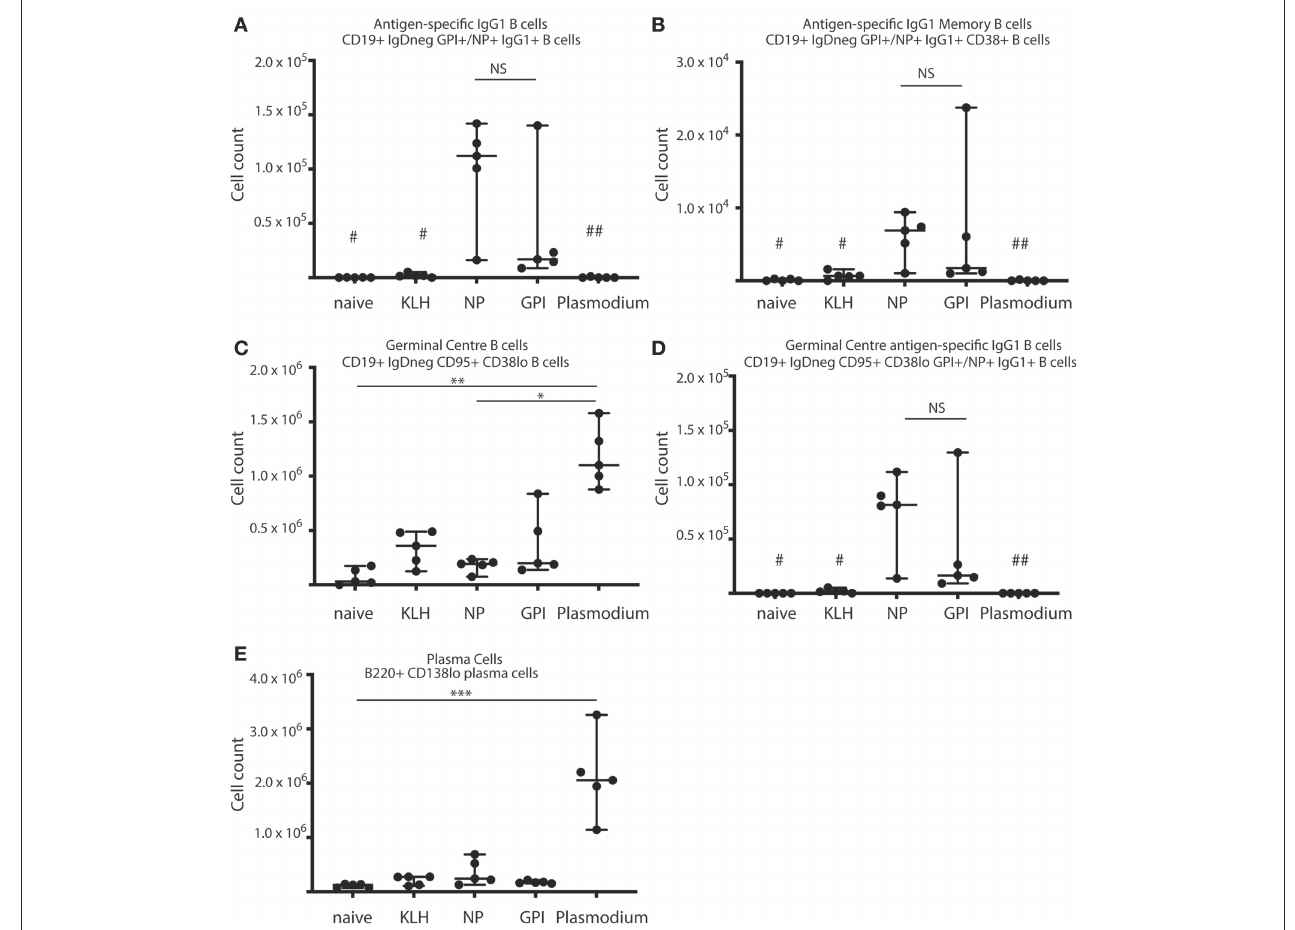
FIGURE 1 | Synthetic GPI-KLH vaccination induced B cell activation. Mice were vaccinated and boosted with NP-KLH ( n = 5), GPI-KLH ( n = 5), or KLH alone ( n = 5) (20 µ g/ µ L) or infected twice with 10 6 pRBCs then 10 4 pRBCs (Plasmodium, n = 5). Naïve mice ( n = 5) were included as a baseline. At day 21, activated B cell populations were analyzed by flow cytometry and the number of cells per spleen for (A) antigen-specific IgG1 B cells, (B) antigen-specific IgG1 memory B cells (MBCs), (C) germinal center (GC) B cells, (D) antigen-specific IgG1 GC B cells, and (E) Plasma cells (PCs) were determined for each mouse. Pooled data from all mice are represented as median ± 95%CI. Data was analyzed using the non-parametric Kruskal-Wallis test and differences determined by Dunn’s multiple comparisons test. Significance was determined at P < 0.05. NS not significant, # naïve and KLH-immunized mice were significantly different to both groups of NP-KLH and GPI-KLH mice P < 0.05, ## Plasmodium mice were significantly different to GPI-KLH mice P < 0.01, * P < 0.05, ** P < 0.01, *** P <